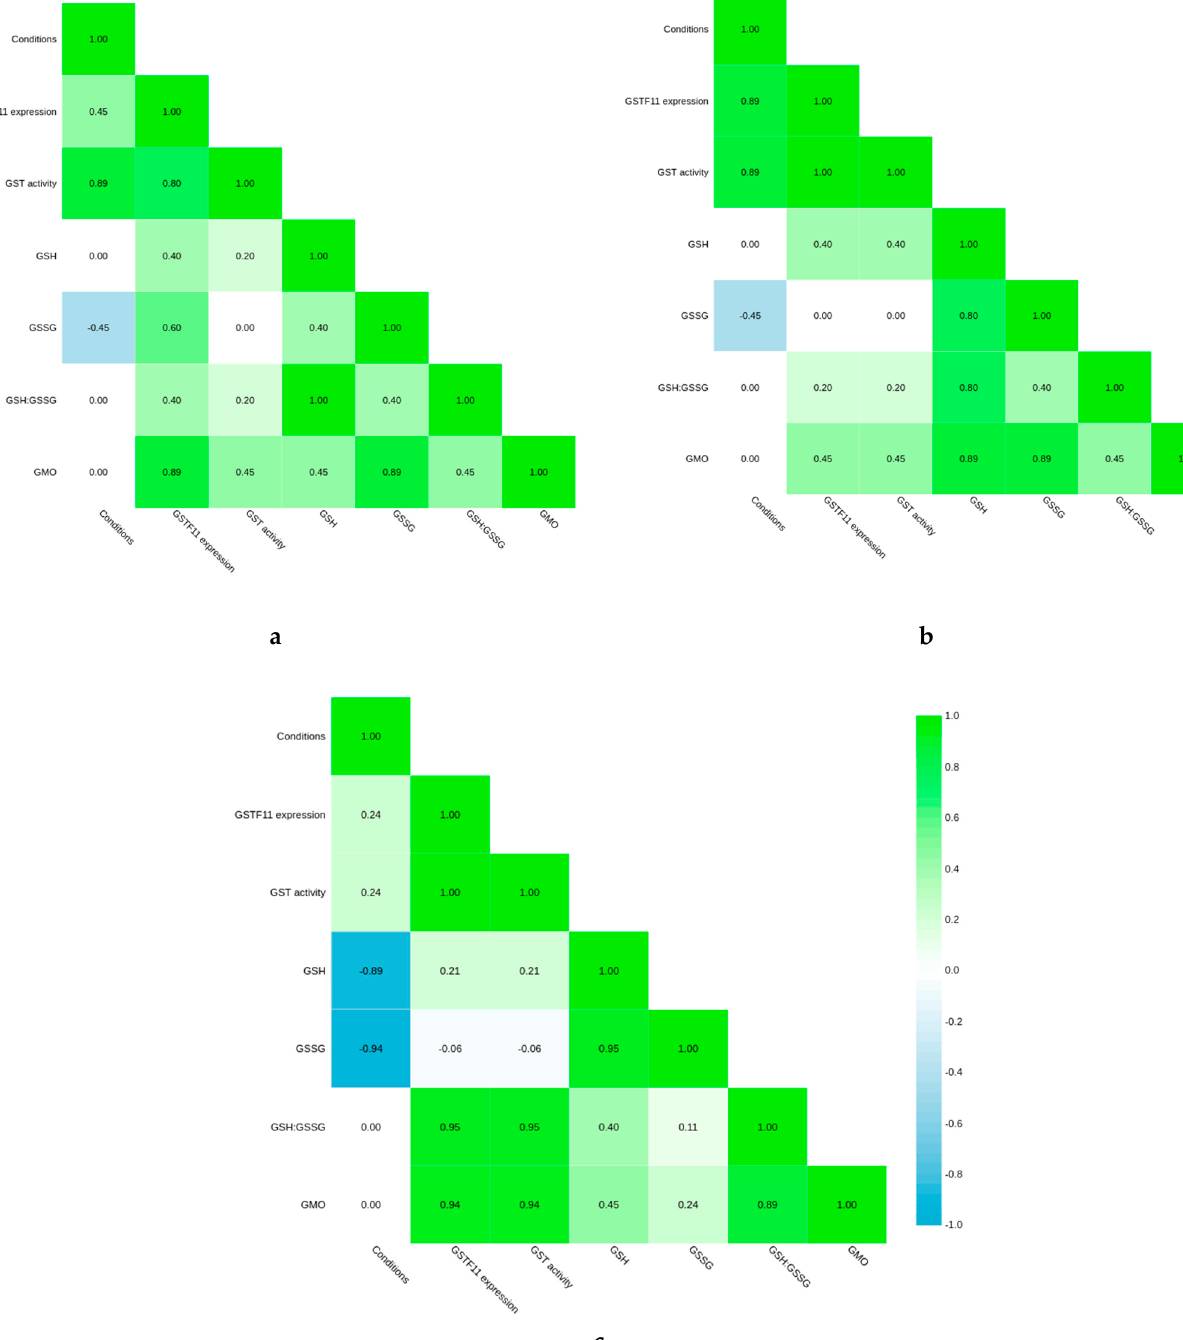
Figure 7. Correlation matrix representing the correlation between the transgene presence (GMO), GSTF11 gene expression, experimental conditions and physiological parameters in ( a ) Resistant plants; ( b ) Susceptible plants; ( c ) Untreated plants.